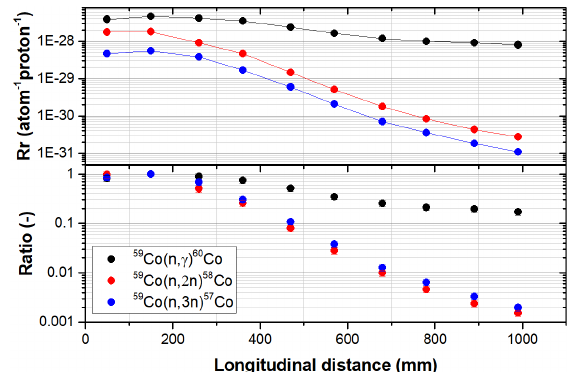
Figure 5. Determination and comparison of 59 Co ( n ,γ ) 60 Co , 59 Co ( n , 2 n ) 58 Co , and 59 Co ( n , 3 n ) 57 Co reaction rates at lead ex- periment.